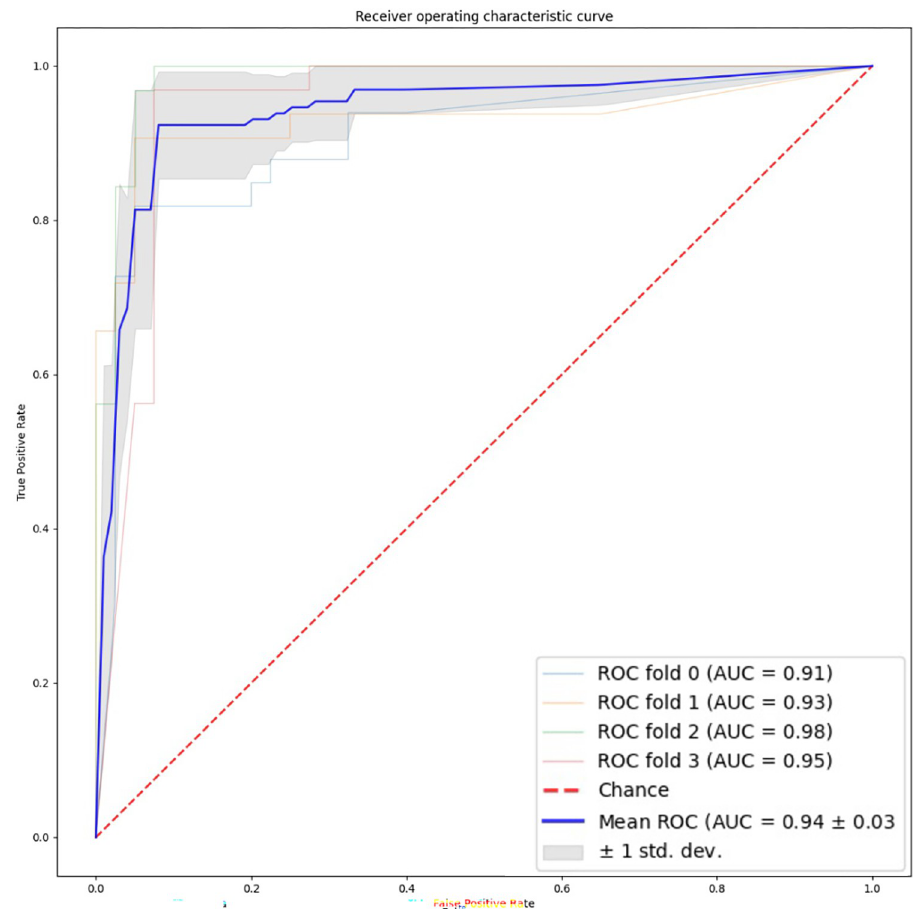
Fig 5. Receiver operating characteristic plot summarizing performance of all four cross validation